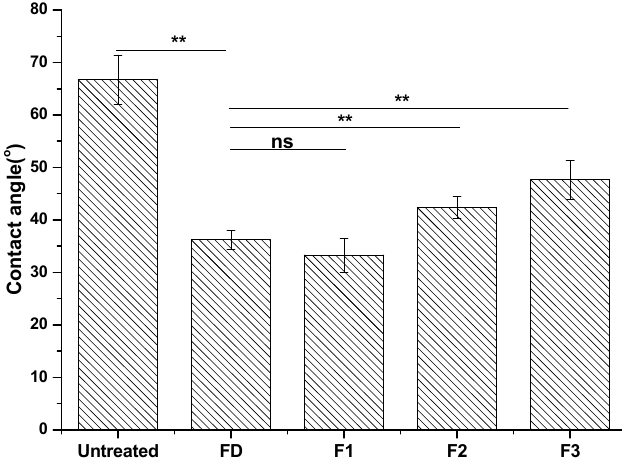
Figure 3. Contact angles of 304 stainless steel samples before and after surface treatment by DA and three cyclotides (P1, P2, and P3). Metal disk samples treated with DA, P1, P2, and P3 were denoted as FD, F1, F2, and F3, respectively. One-way analysis of variance (ANOVA) was used to compare groups (ns: not significant; ** p < 0.01, n = 4). Error bars indicate the standard deviation of the four independent measurements.